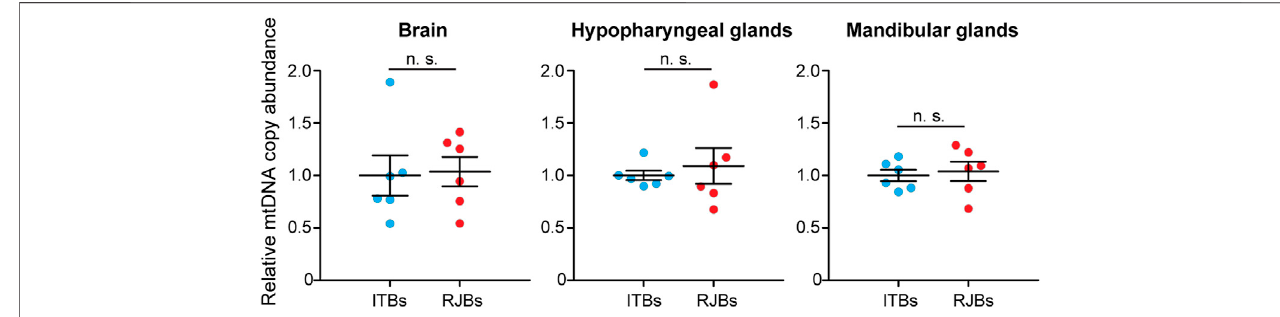
FIGURE 2 | Relative mtDNA copy number between RJBs and ITBs. mtDNA copy number was compared in the brain, hypopharyngeal glands, and mandibular glands. The mtDNA copy abundance in RJBs was normalized to that (mean = 1.0) in ITBs (mean ± SEM, n = 6 for each strain). No signi fi cant difference was found.